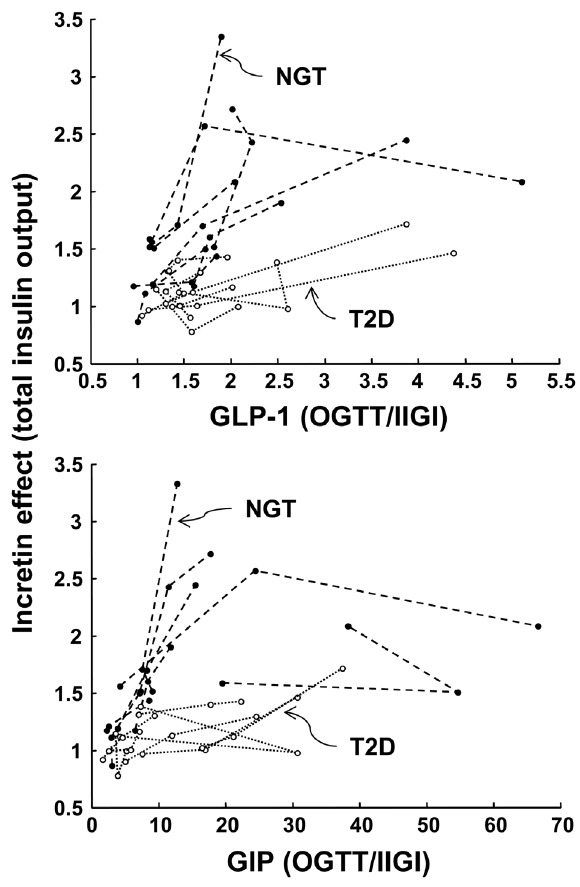
Figure 7. Individual relationships between incretin effect and incretin hormones. Individual trajectories for the relationship between the incretin effect on total insulin secretion and the mean OGTT/IIGI ratio of GLP-1 and GIP concentrations in NGT and T2D participants.